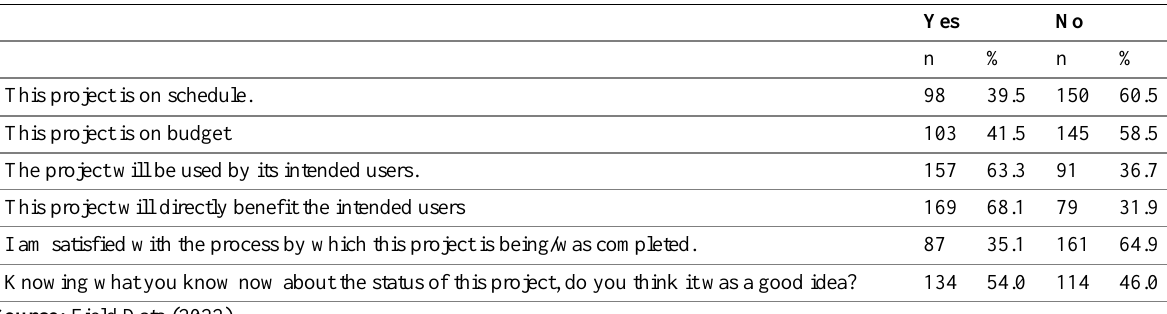
Table 5 : Status of Projects